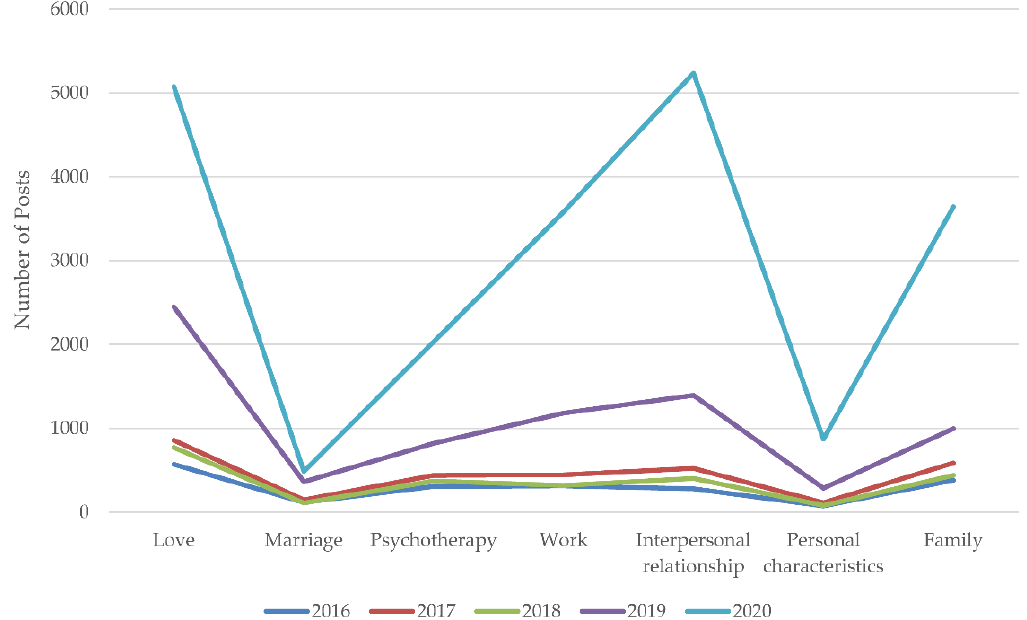
Figure 4. The yearly trends of posts related to different influential factors before and during the COVID-19 pandemic.